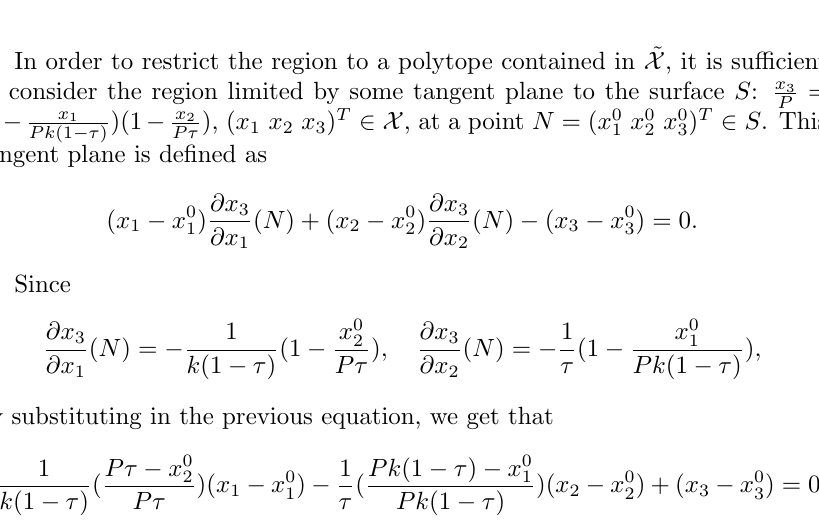
Figure 1. Initial admissible polytope X and set ˜ X under conditions given by Proposition 3, in Example